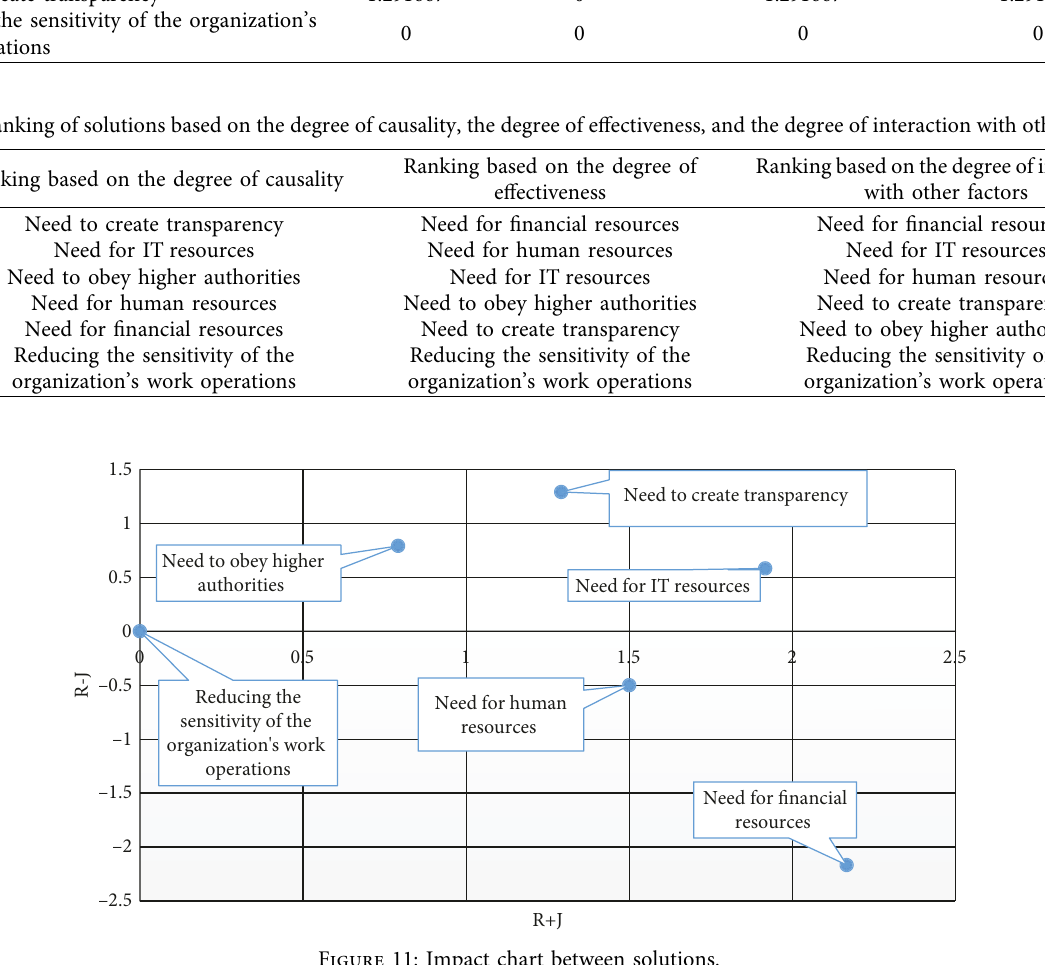
Figure 11: Impact chart between